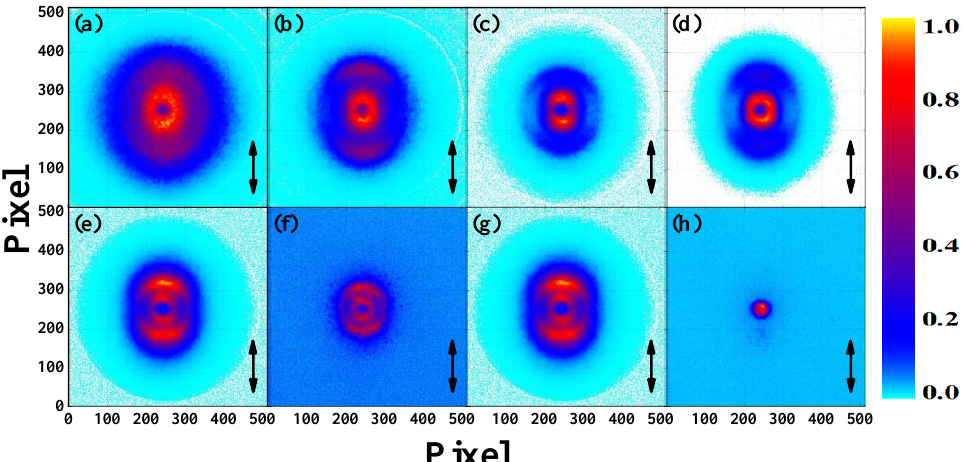
Figure 2. The sliced images of the ions ( a ) CH 2+ , ( b ) C 2 H 3+ , ( c ) C 3 H 3+ , ( d ) C 3 H 5+ , ( e ) Br + , ( f ) CH 2 Br + , ( g ) C 2 H 3 Br + and ( h ) C 3 H 5 Br + with the laser intensity of 1.0 × 10 14 W/cm 2 and the double black arrows represent the direction of laser polarization vector. The color map of each image is normalized to 1, individually.